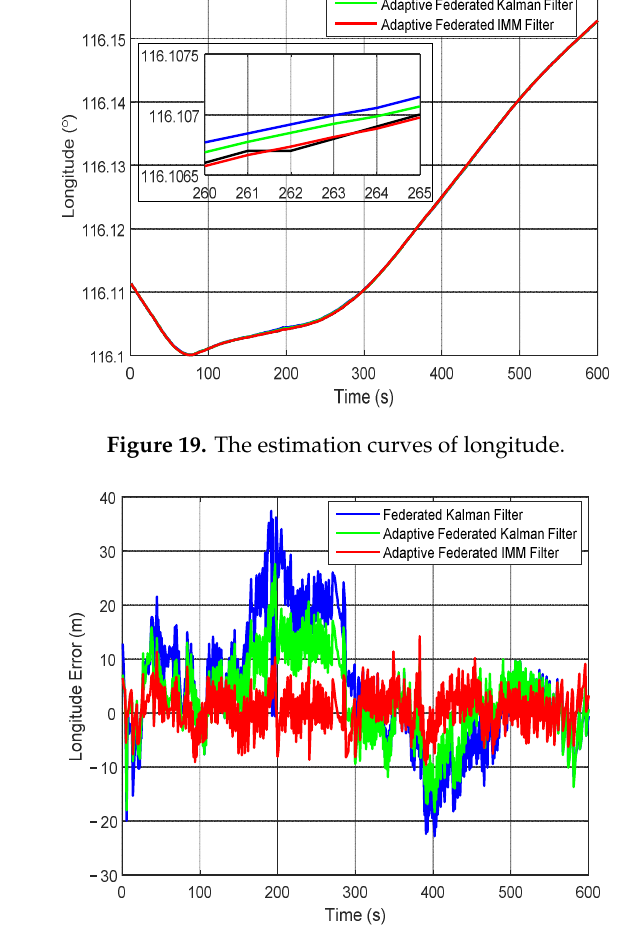
Figure 20. The estimation curves of longitude error.